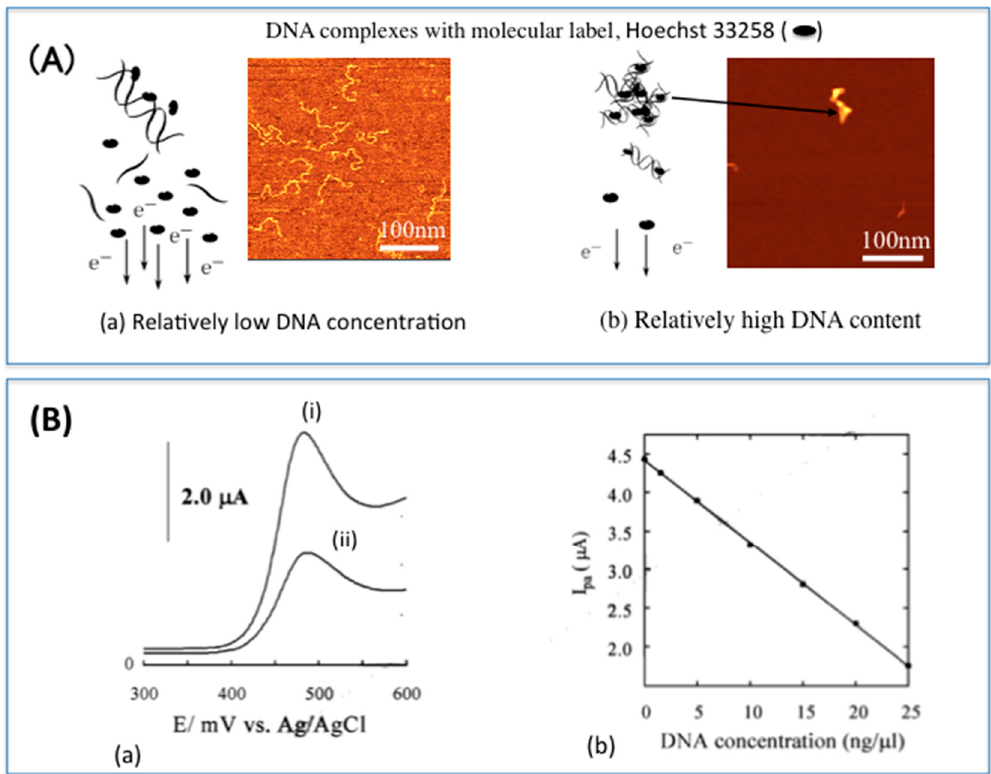
Figure 2. The principle of electrochemical DNA detection using Hoechst 33258 at disposable electrochemical printed (DEP) chips. ( A ) Hoechst 33258 interacts with the DNA resulting in a slow diffusion coefficient of the molecular label to the electrode surface ( a ); When DNA is amplified there is more interaction of DNA with the molecular label and aggregate formation, resulting in even slower diffusion of the molecular label to the electrode surface ( b ); ( B ) Voltammograms showing anodic peak currents of Hoechst 33258 after intercalation (i) with DNA at relatively low concentration; and (ii) amplified DNA. When the DNA is amplified, more Hoechst 33258 intercalates the DNA resulting in higher decrease in current detected ( a ); The degree of interaction is proportional to the current detected ( b ). Part of this figure was used in our original work [52]).